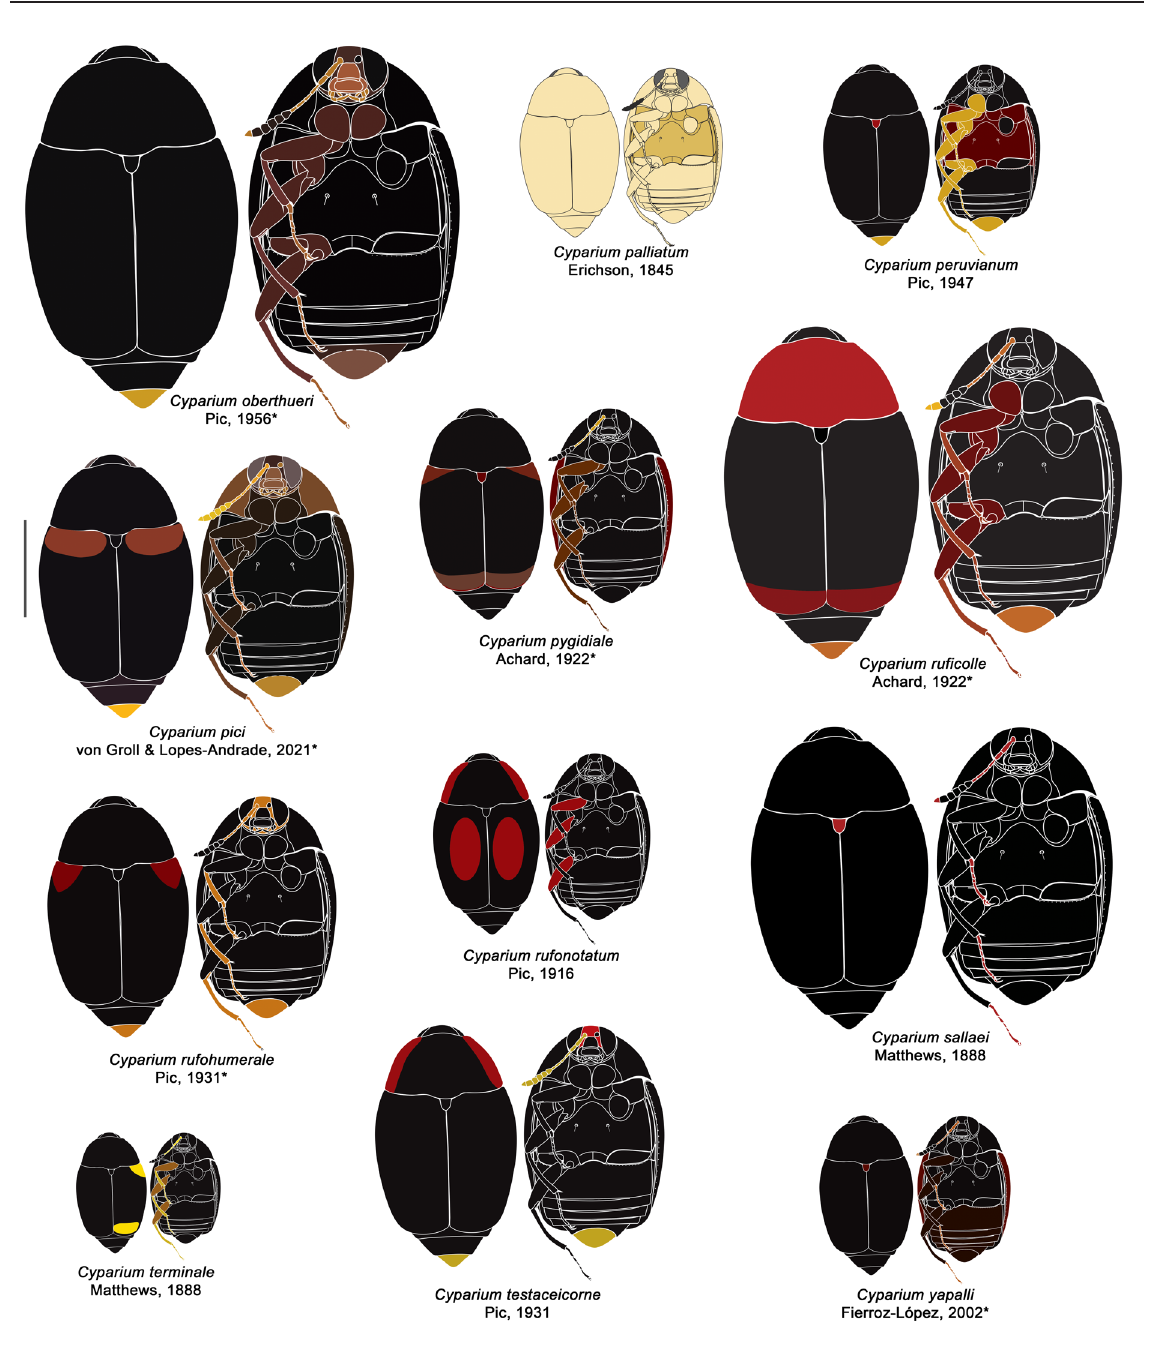
Fig. 5. Cyparium Erichson, 1845 . Neotropical species. Illustrations based on the original descriptions. *Illustrations made based on photographs, specimens, or illustrations made by other authors. Model: Cyparium collare Pic, 1920. Scale bar = 2